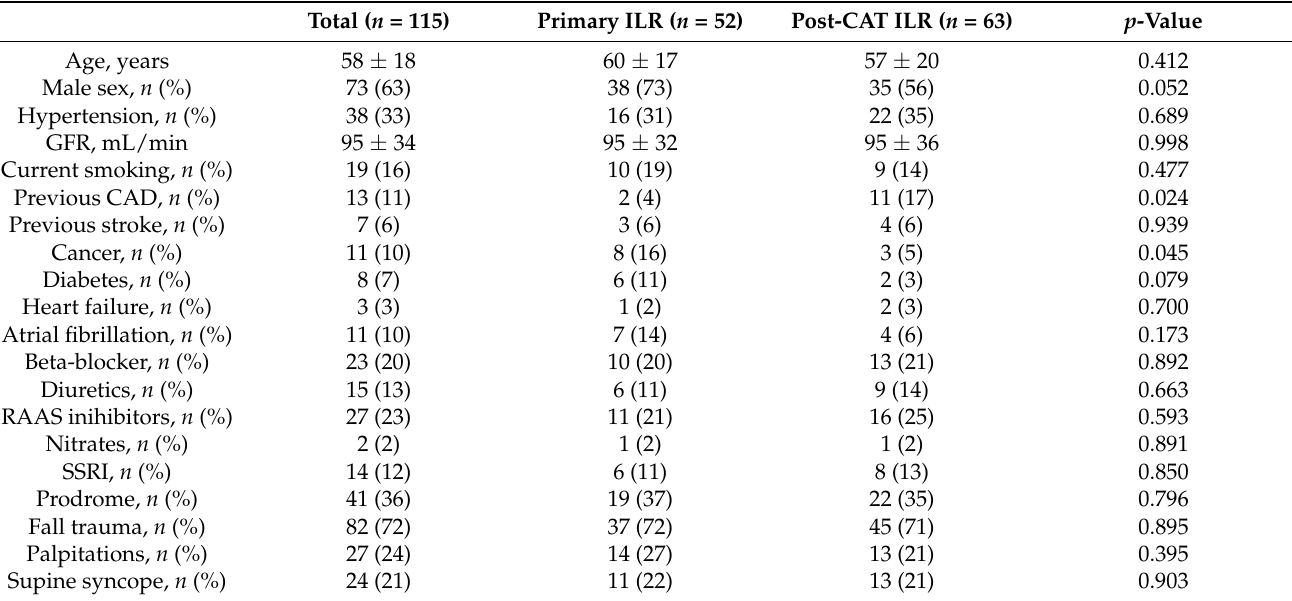
Table 1. Baseline characteristics by diagnostic